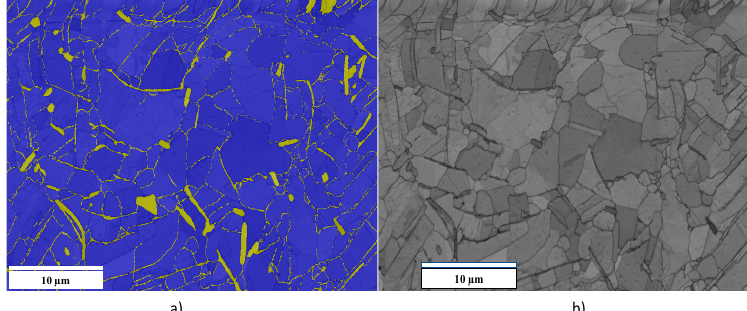
Figure 8. Backscattered electron Kikuchi patterns (EBSKP) indexing of Sample B. ( a ) SEM image; ( b , c ) nickel γ -phase (blue) and δ -phase (yellow) EBSKP overlay, respectively.